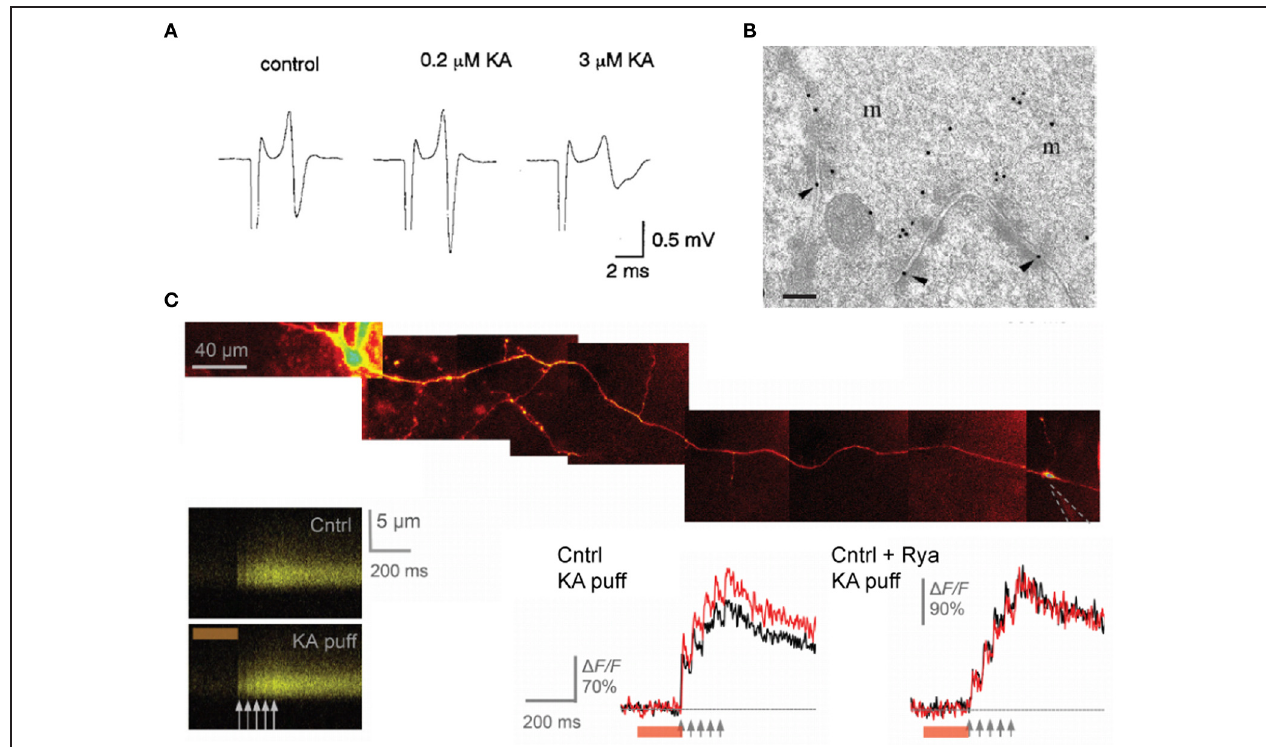
FIGURE 6 | presynaptic kainate receptors modulate mossy fiber excitability and Ca 2 + influx in single varicosities. (A) Representative traces of the afferent volley before and during superfusion of low and high doses of kainate, as indicated. (B) High-magnification micrograph of stratum lucidum showing a mossy fiber terminal labeled with antibody fragments directed against GluK4. Immunogold particles are found along the presynaptic membrane. Scale bar, 20nm. (C) Local kainate application mobilizes Ca 2 + -store and boosts action-potential-evoked Ca 2 + entry in giant mossy fiber boutons. Top, a granule cell axon is traced from the